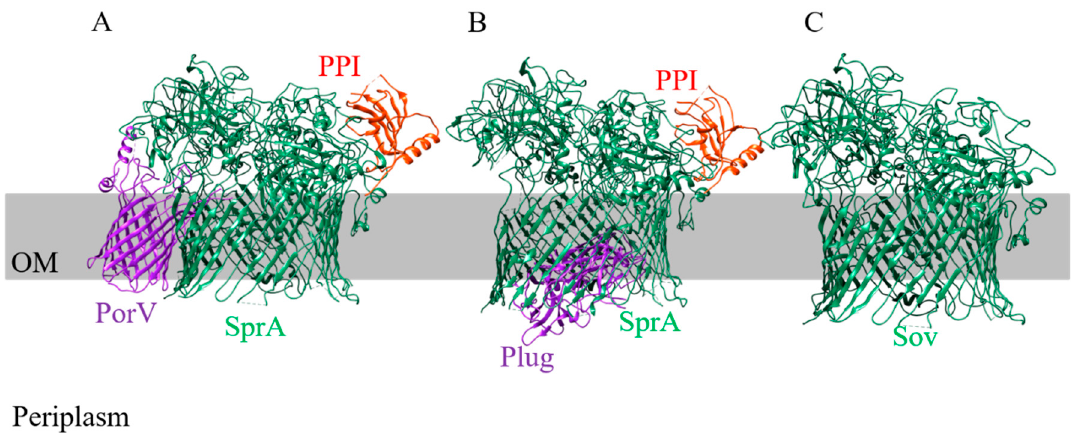
Figure 1. Cryo-EM structure of SprA complexes. ( A ) SprA bound to PorV at the lateral opening. ( B ) SprA bound to the Plug at the periplasmic opening. ( C ) Phyre 2 modelled structure of Sov [35]. The PDB entries (www.rcsb.org) for the structures shown are: SprA-PorV-PPI (6H3I) and SprA-Plug-PPI (6H3J). OM: outer membrane